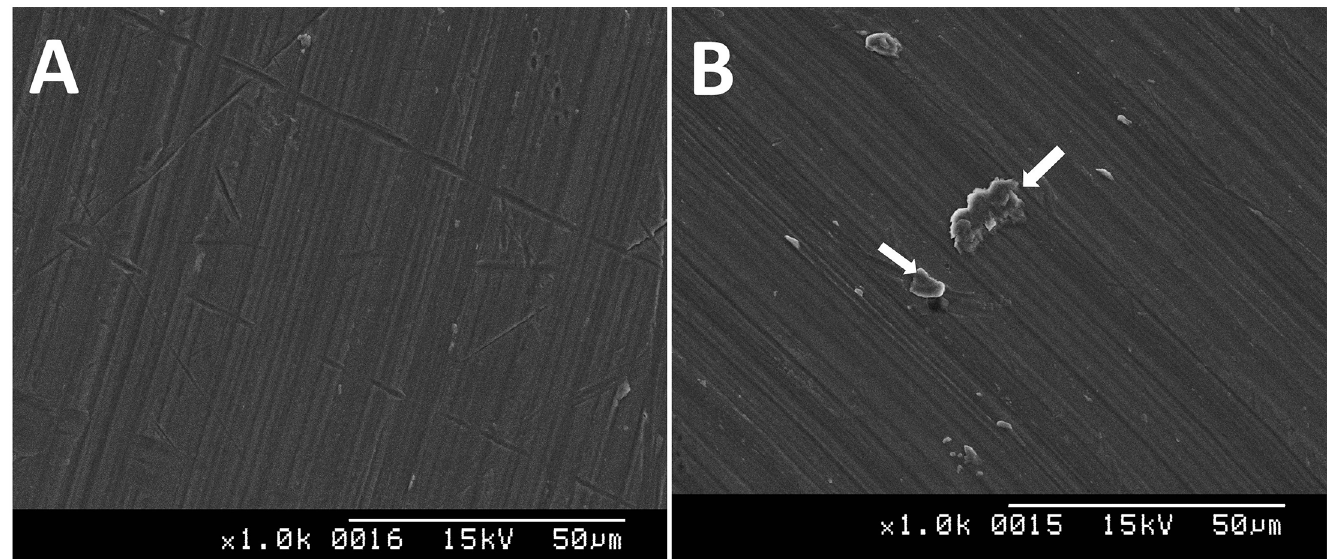
Fig 3. Scanning electron microscopy images of the Ar-GDP (a) and GDP-fib (b) titanium discs. Irregular folding of the fibronectin was revealed on the surface of fibronectin-grafted titanium disks (white arrows) .